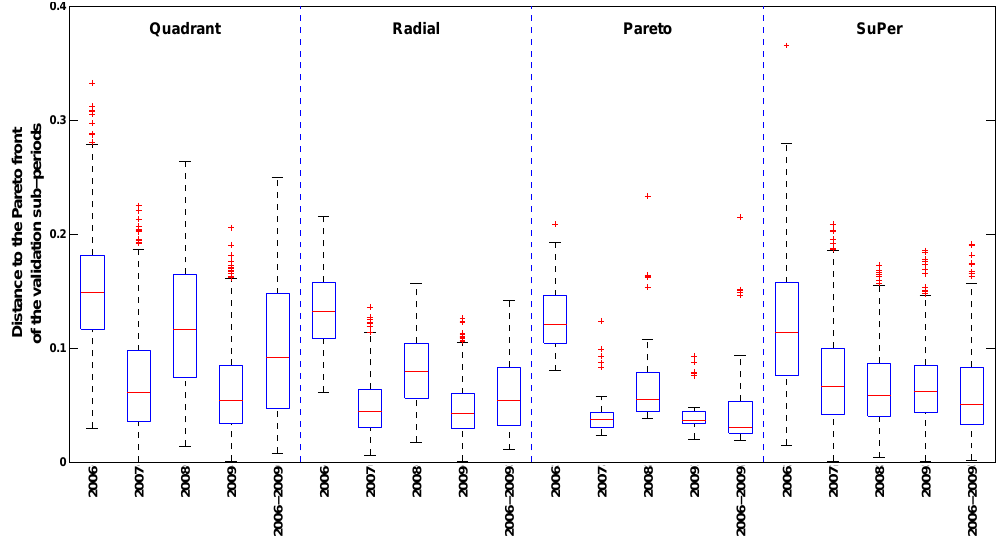
Fig. 8. Distribution of Euclidian distance or relative performance of behavioral parameter sets obtained by calibration, and parameter sets retained by MDPF 1998 − 2005 to calibration Pareto fronts of the individual year and the entire validation period (CPF 2006 , CPF 2007 , CPF 2008 , CPF 2009 , CPF 2006 − 2009 ). Whiskers represent the 1.5 times the interquartile range (IQR) and the red crosses show outliers.